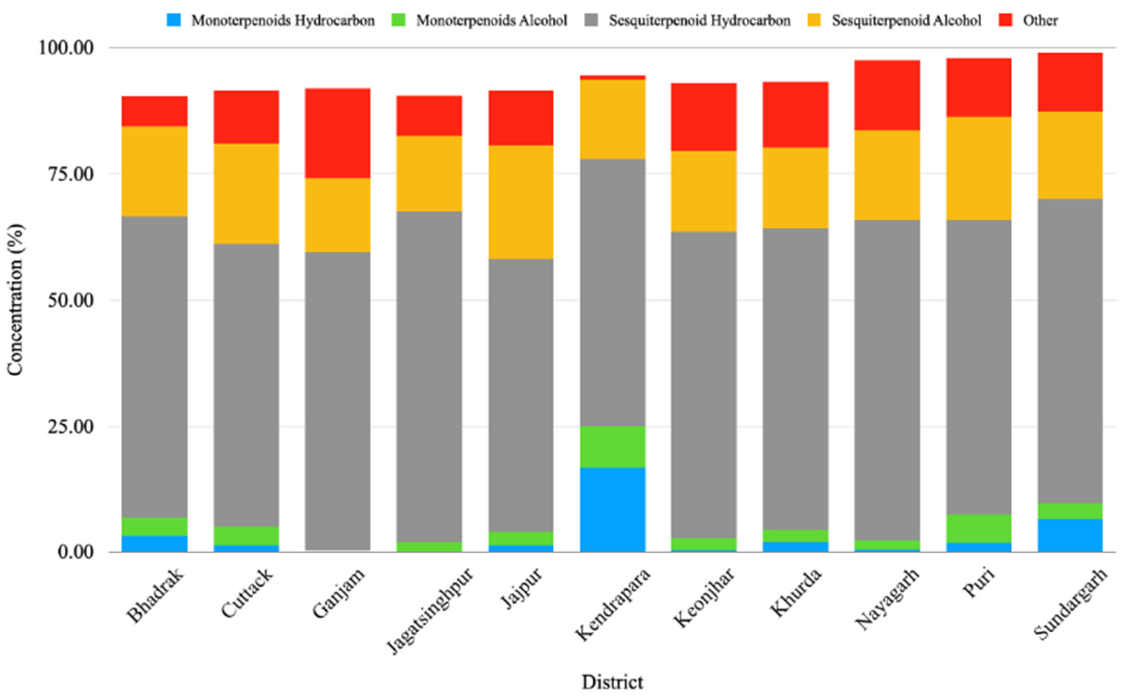
Figure 1. Relative percentages of chemical constituents’ classes in the essential oil of Magnolia champaca from different regions of Odisha, India.